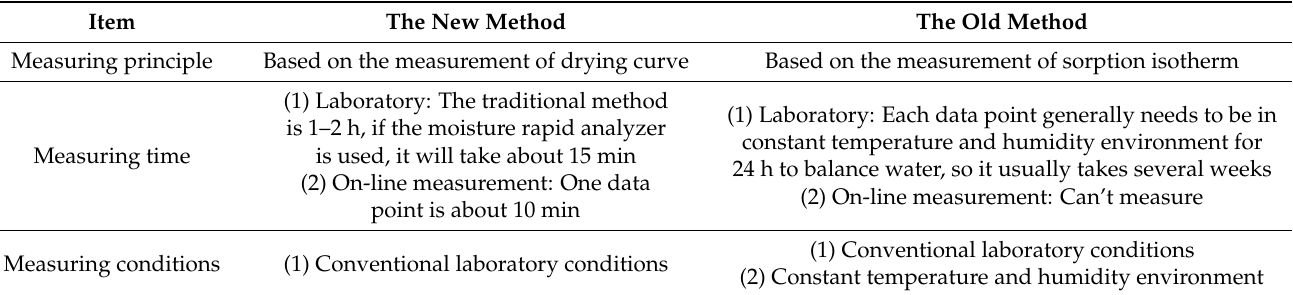
Table 1. Comparison of new and old methods.